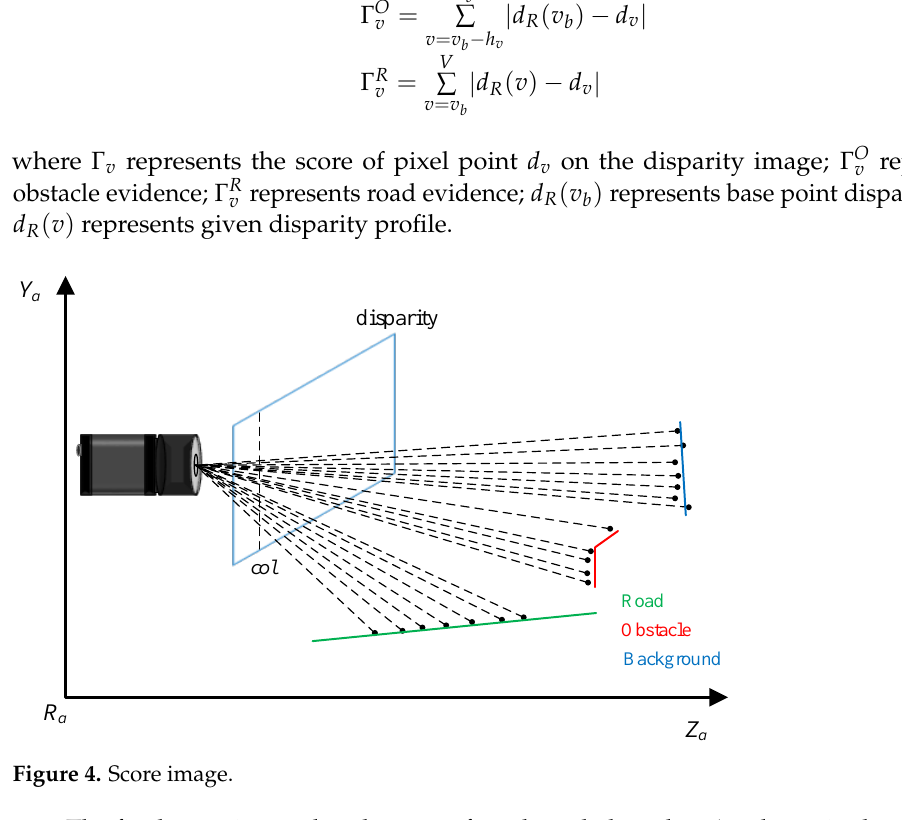
(d) Figure 5. Obstacle detection result: ( a ) obstacle disparity; ( b ) vertical line segment fitting; ( c ) hori- zontal line segment fitting; and ( d ) obstacle detection.